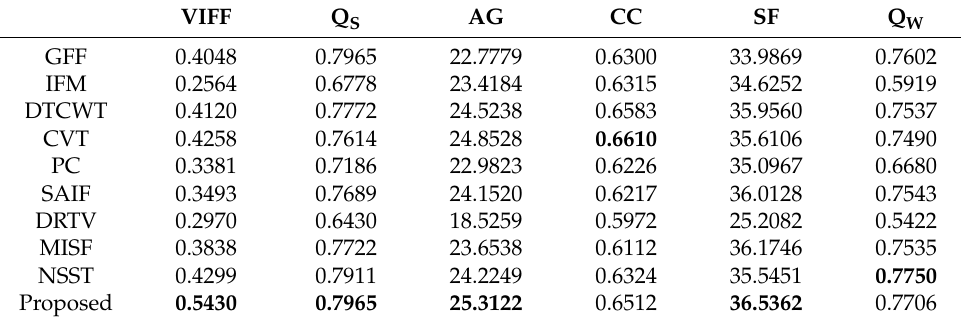
Table 3. The objective evaluation of the methods in Figure 6.